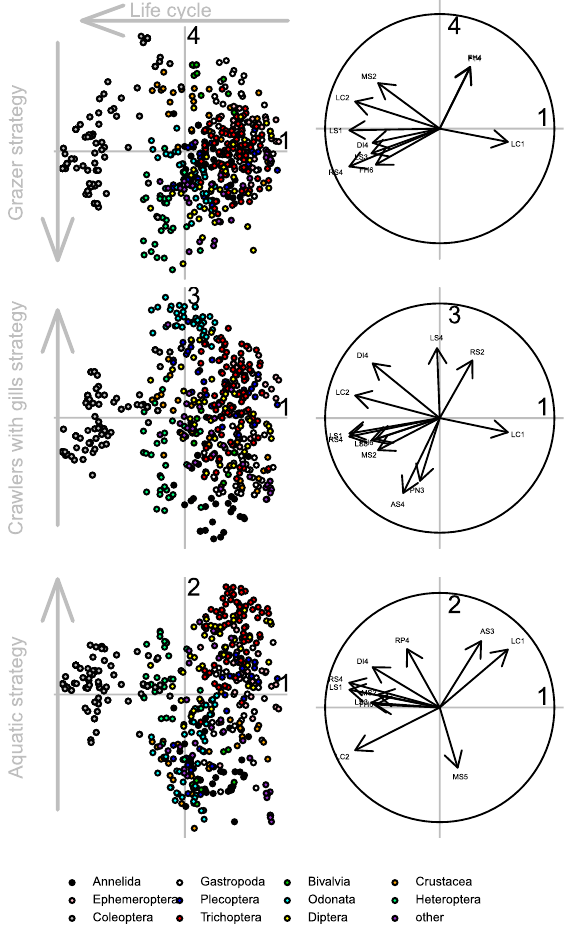
Figure 1. Centred Principal Component Analysis (PCA) ordination of freshwater macroinvertebrate taxa (left) according to their functional traits (right). The first four PCA axes (indicated by numbers) are depicted in three pairwise combinations (axis 1 versus axis 2, 3 or 4) and only functional traits with correlation r >|0.5| with at least one axis are shown. Grey arrows are used to interpret ecological strategies along the axes. See Table 4, for abbreviations of traits.